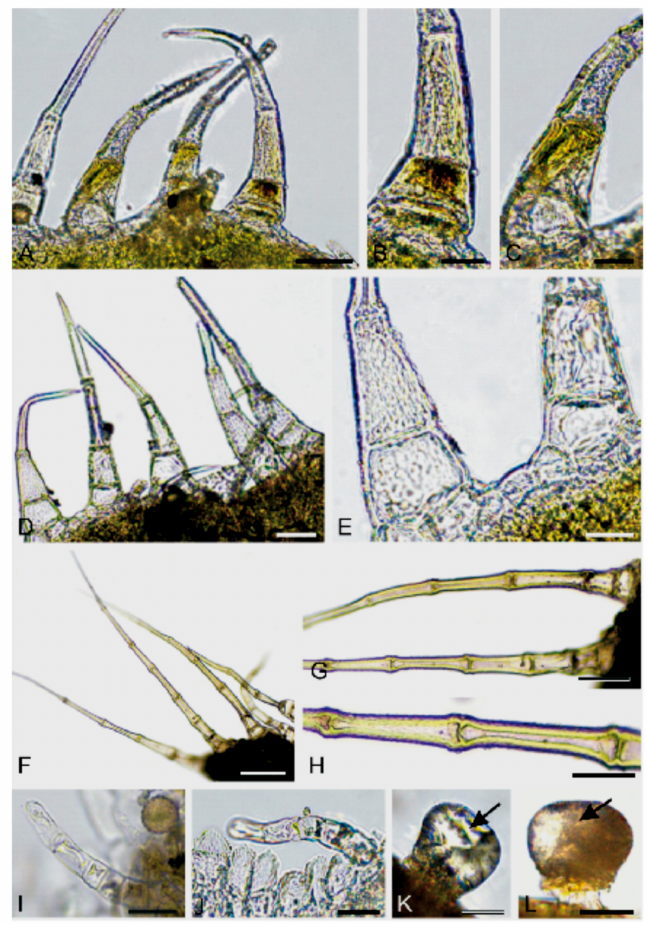
Figure 9. Different types of trichomes from Artemisia artemisiifolia male inflorescences: ( A – E ) short non-glandular trichomes; ( A – C ) trichomes with yellow–green cell content; ( D , E ) trichomes with transparent content and visible cell wall ornamentation; ( F – H ) long non-glandular trichomes; ( I , J ) linear glandular trichomes; ( K , L ) biseriate glandular trichomes with secretory product in subcuticular space (arrow); Scale bars: F —200 µ m, G , H —100 µ m, A , D , I , J —50 µ m, K , L —30 µ m, B , C , E —20 µ